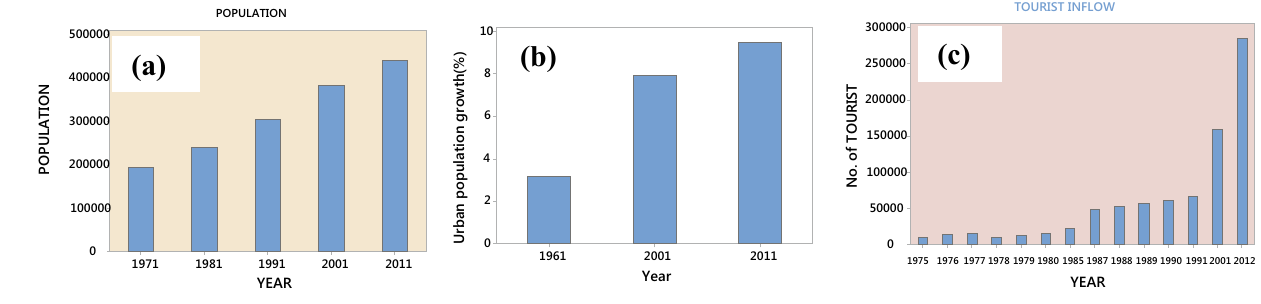
Fig. 3 a Decadal growth of population (source: Statistical abstract of Kullu 2014), b population growth in Urban area (source: Statistical abstract of Kullu 2014) and c tourist inflow rate in Kullu District, Himachal Pradesh (source: Department of Tourism